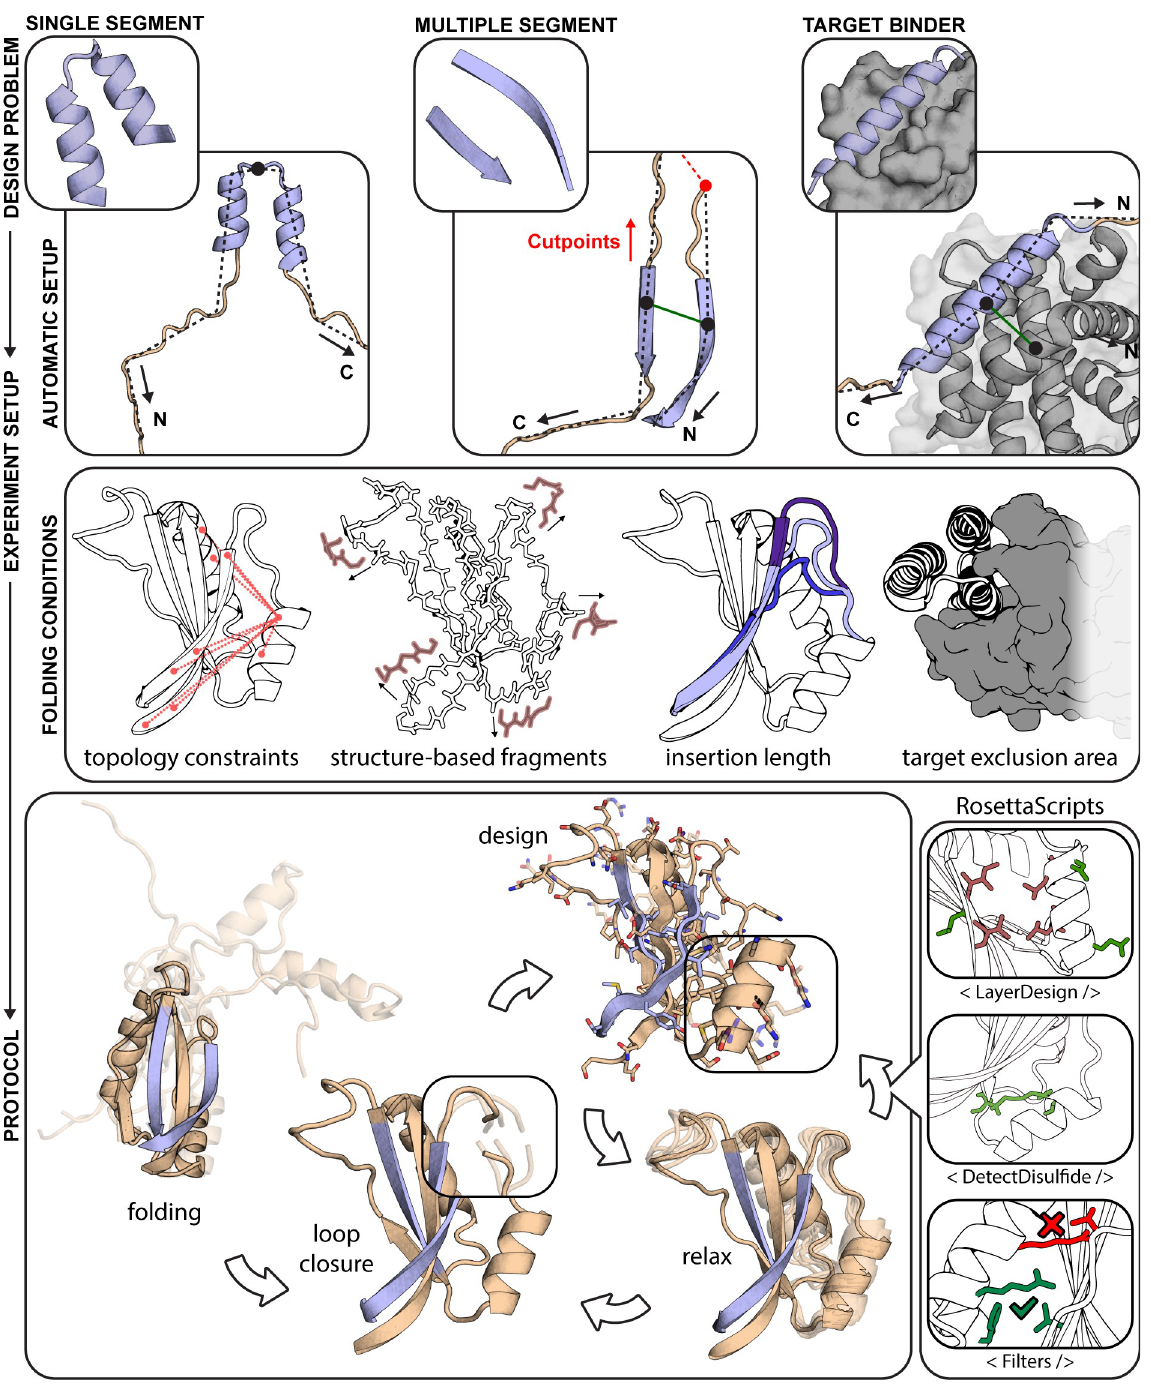
Fig 1. Rosetta FunFolDes—Method overview. FunFolDes was devised to tackle a wide range of functional protein design problems, combining a higher user control of the simulation parameters whilst simultaneously lowering the level of expertise required. FunFolDes is able to transfer single- and multi-segment motifs (light blue) together with the target partner (grey) by exploiting Rosetta’s FoldTree framework (top row). A wider range of information can be extracted from the template (wheat) to shift the final conformation towards a more productive design space (middle row), including targeted distance constraints, generation of structure-based fragments, motif insertion in sites with different residue length and presence of the binding target to bias the folding stage. The bottom row showcases the most typical application of the FunFolDes protocol. Implementation in RosettaScripts allows to tailor FunFolDes behavior. A seamless integration with other protocols and complex selection logics can be added to address the different needs in each design task.